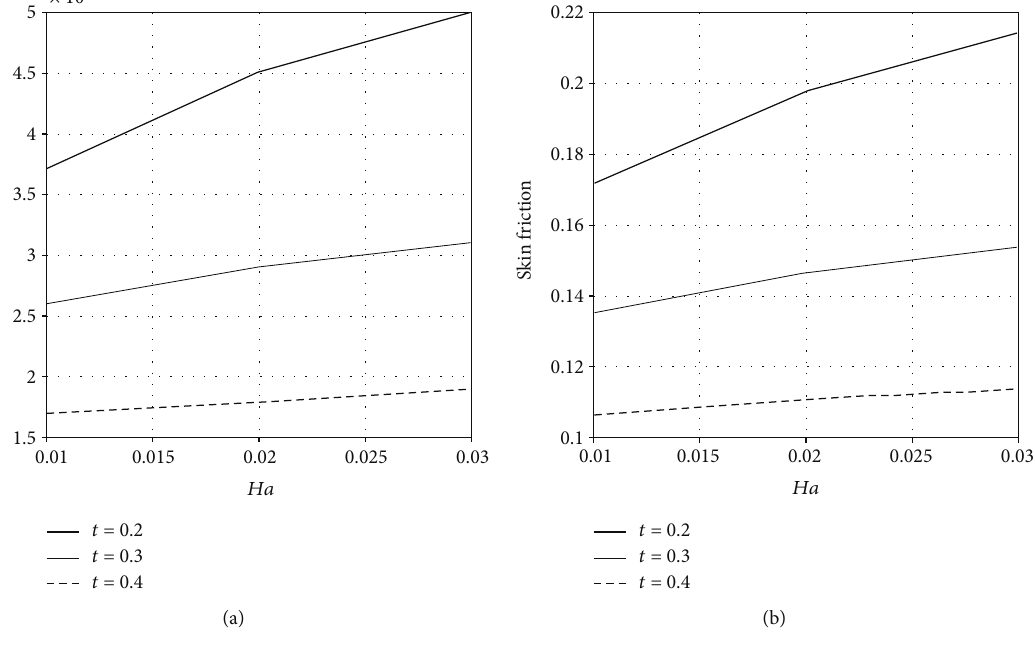
Figure 7: Skin friction for Ha 2 in proportion to t